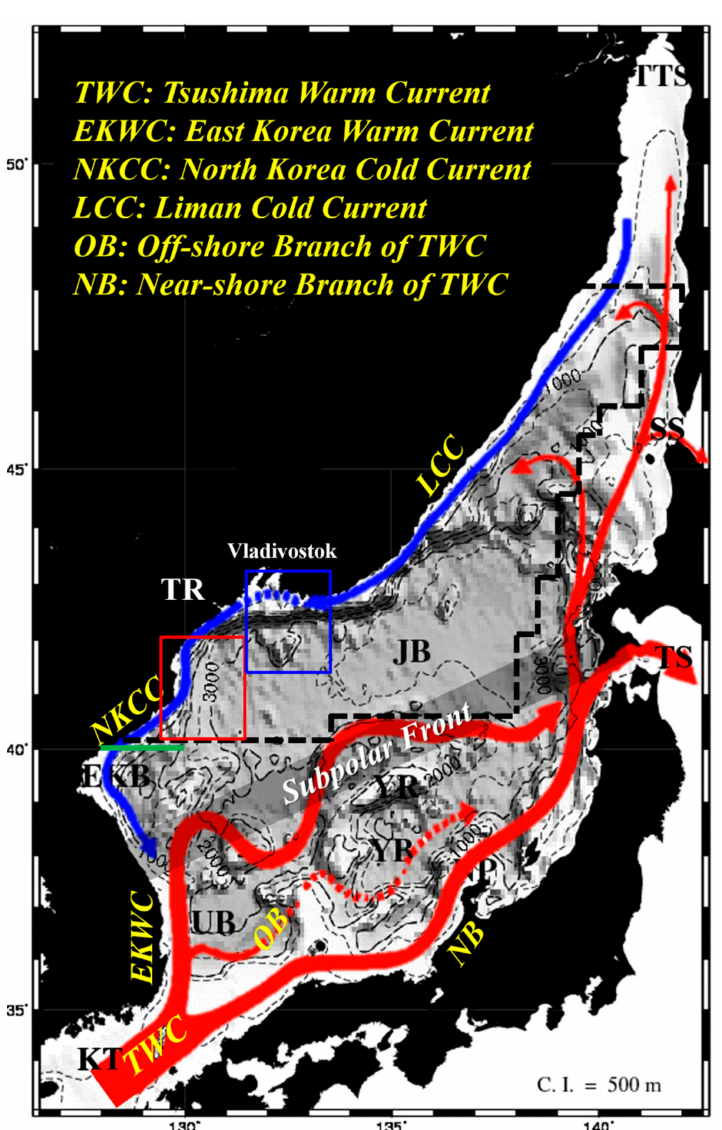
Figure 1. Bathymetry and the major currents in the East Sea. Abbreviations for the major currents are on the upper-left. The red and blue arrows denote warm and cold currents [9]. TR: Tumen River mouth, KTS: Korea/Tsushima Strait, TS: Tsugaru Strait, SS: Soya Strait, TTS: Tatar Strait, UB: Ulleung Basin, YB: Yamato Basin, JB: Japan Basin, YR: Yamato Rise, EKB: East Korean Bay, NP: Noto Peninsula. The area surrounded by a black dashed line denotes the region where empirical orthogonal function (EOF) analysis of sea surface height (SSH) was conducted in the northern East Sea (NES). The red and blue boxes in the northwestern region of the East Sea demarcate the area used for area mean. The green line along 40 ◦ N denotes the estimation of the heat and freshwater